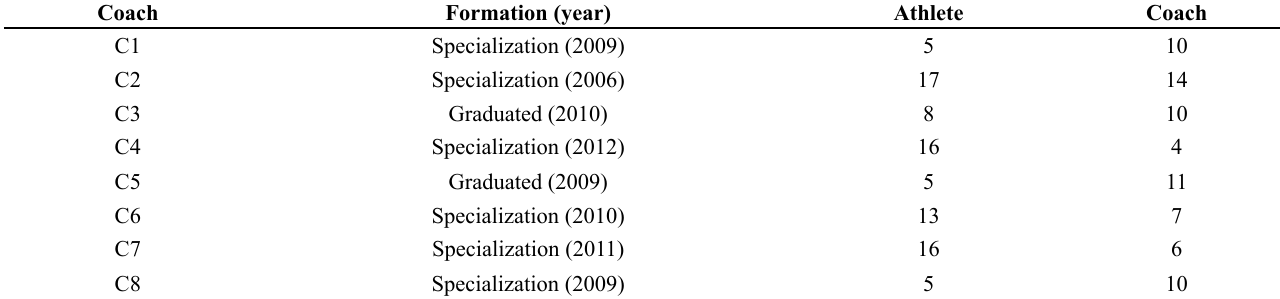
Table 1 Formation, years of athletic experience and coaching. Coach